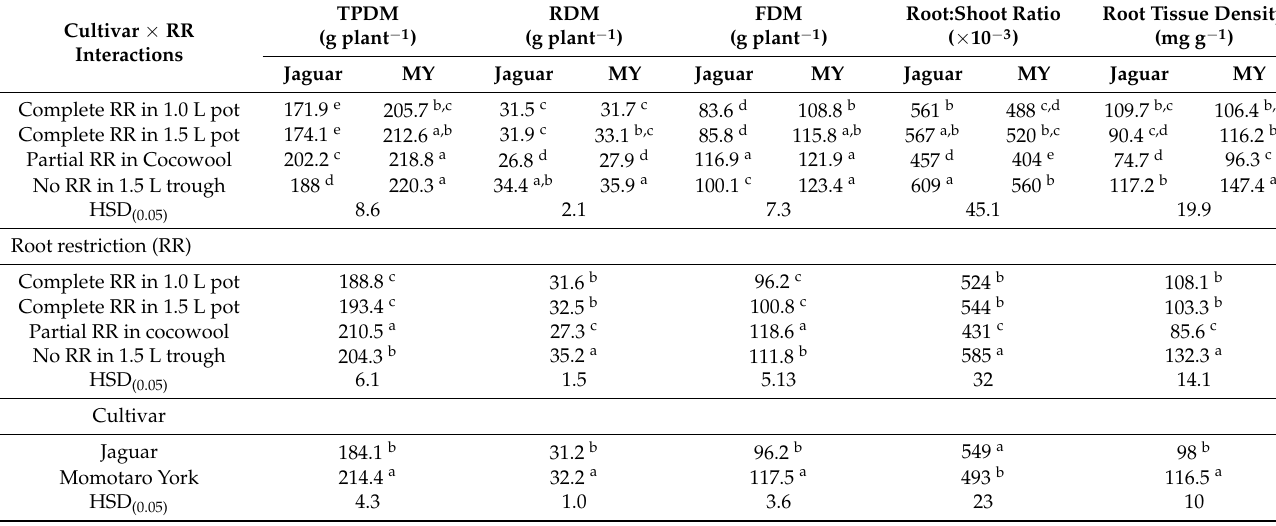
MY = Momotaro York; TPDM = total plant dry matter; RDM = dry matter partitioned to root; FDM = dry matter partitioned to fruit; WAT = weeks after transplanting; Figures followed by the same letter in a column are not significantly different according to Tukey’s